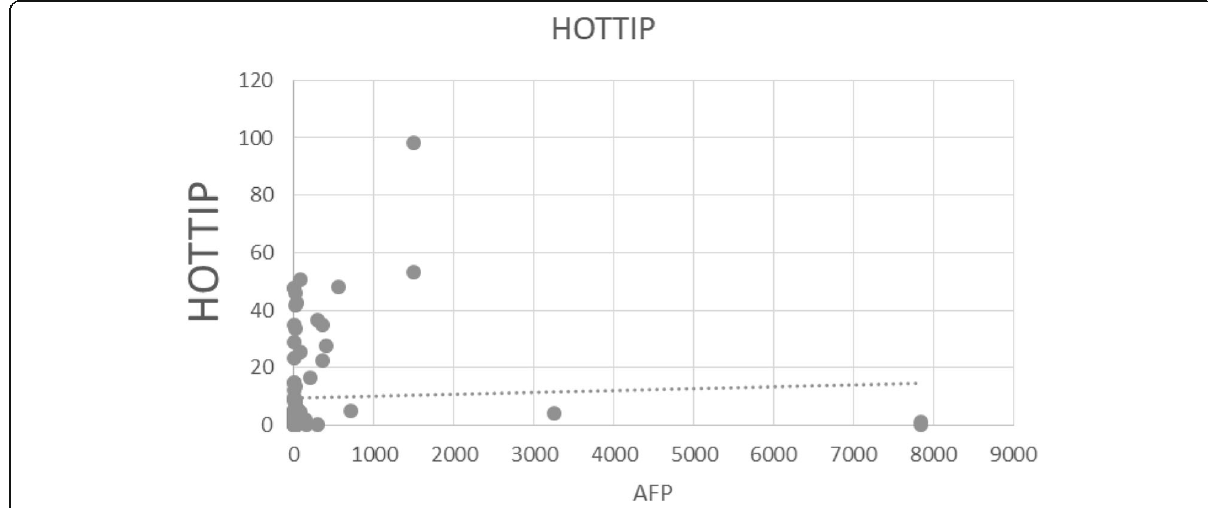
Fig. 5 Correlation between HOTTIP and AFP